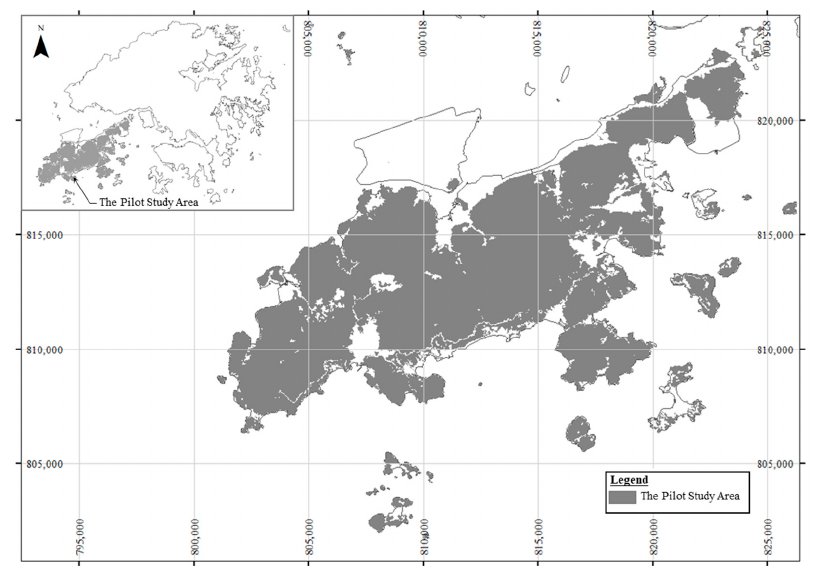
Figure 4. Extent of the Study